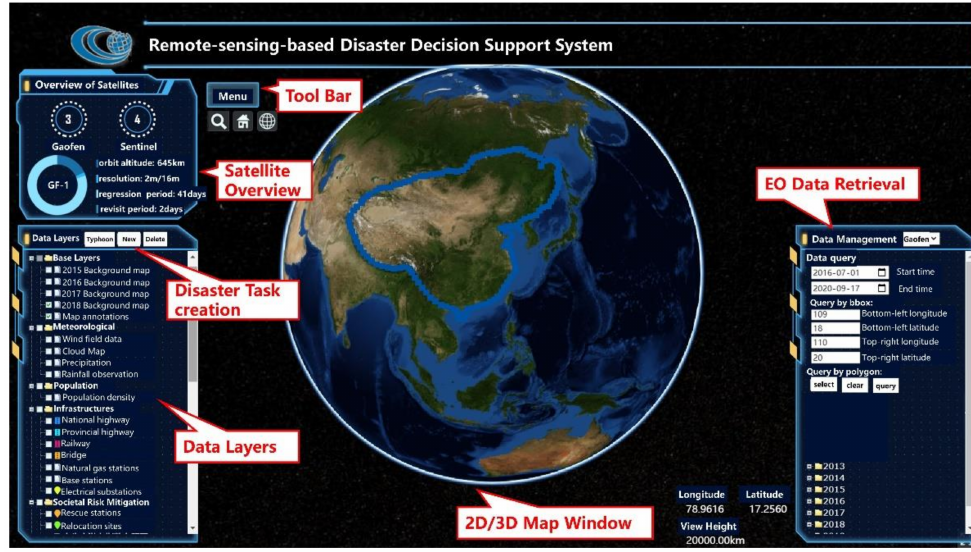
Figure 3. User interface of